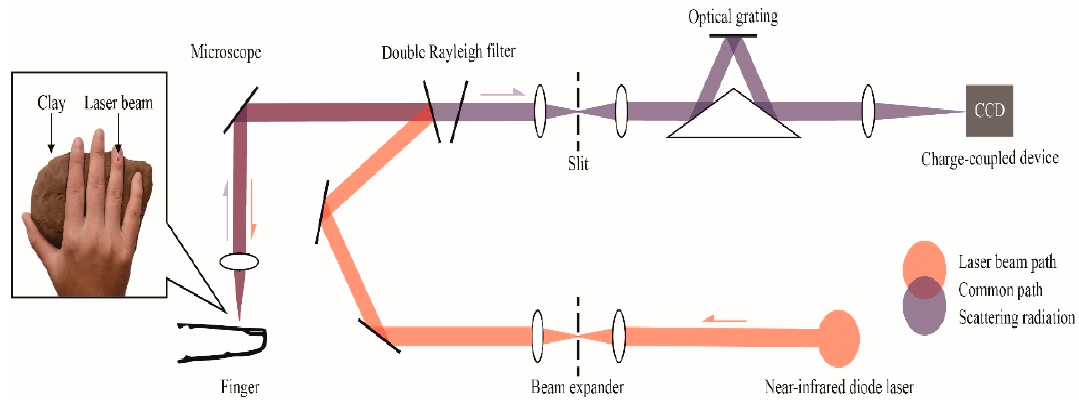
Figure 7. Raman spectroscopic apparatus for noninvasive glucose measurement. An inset shows the detection site located in the right hand of the volunteer, volunteers’ hands are placed on clay to reduce motion artifacts.